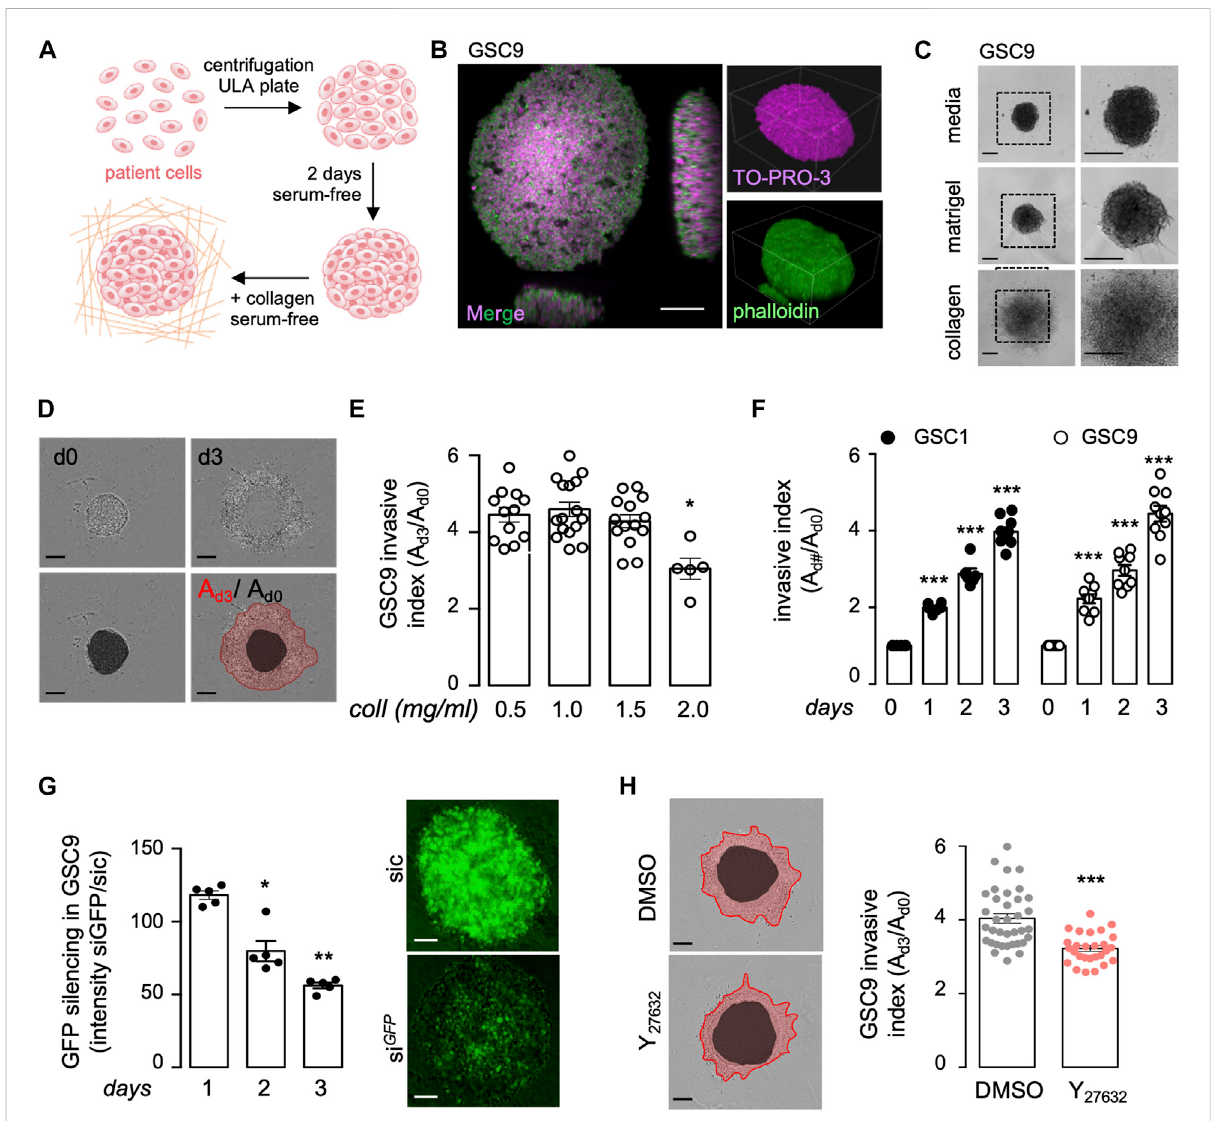
FIGURE 1 Collagen/integrin-based 3D invasion of glioblastoma patient-derived cells. (A) Schematic representation of the experimental design to assess spheroid formation andinvasion. Brie fl y,8,000 glioblastoma stem-like patient-derived cells(GSCs) were dissociated, centrifuged, and incubated for 2 days in a complete medium to allow spheroid formation. Spheroids were then embedded in collagen hydrogel to perform an invasion assay. (B) Spheroids were fi xed, permeabilized, and clari fi ed for further confocal microscopy of TO-PRO-3 (purple) and phalloidin (green) staining. Smaller insights x,y,z: 424 × 424 × 225 μ m, Scale bar: 100 μ m. (C) Representative bright- fi eld images of spheroids fl oating in their complete serum- free media or embedded in matrigel and collagen for 2 days. Scale bars: 300 μ m. (D) Typical bright- fi eld images were acquired on days 0 (d0) and 3 (d3).Theinvasionindex(Ad3/Ad0)wascalculatedastheratioofthetotalarea (A) foreachspheroidatday3(redline)today0(blackcircle),Scalebars: 300 μ m. (E) 3D invasion assays of 8,000 GSC9 were performed in increasing concentrations of collagen (Coll, 0.5, 1.0, 1.5, and 2.0 mg/ml). Graph represents the mean ± s.e.m. of the invasive index on 5 – 16 spheroids from three independent experiments. (F) 3D invasion assays were performed with 8,000 GSC1 and GSC9 at the indicated time points. Graph represents the mean ± s.e.m. of the invasive index on 5 – 9 spheroids from three independent experiments. (G) GSC9 stably expressing GFP were transfected with non-silencing (sic) or GFP targeting duplexes RNA duplexes (si GFP ). Theknockdownef fi ciencywasevaluated via GFPsignalintensityattheindicatedtimes.Graphrepresentsthemean±s.e.m.ofthesi GFP /sicratioin fi ve spheroids from two independent experiments. Scale bars: 100 μ m. (H) Spheroids were embedded in 1 mg/ml collagen hydrogel and were treated with either vehicle (DMSO) or the ROCK inhibitor (Y 27632 , 50 mM) for 72 h. Graph represents the mean ± s.e.m. of the invasive index on 27 – 36 spheroids from three independent experiments. Representative bright- fi eld images are shown. Scale bars: 300 μ m. All panels are representative of at least three independent experiments unless otherwise stated, t -test and ANOVA, * p < 0.05, ** p < 0.01, *** p <